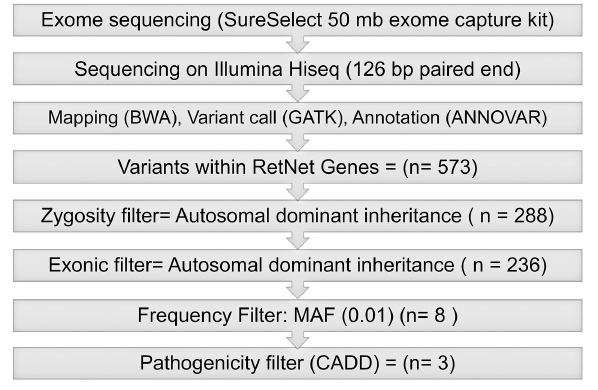
FIGURE 1 | Analysis and filtering pipeline for RetNet